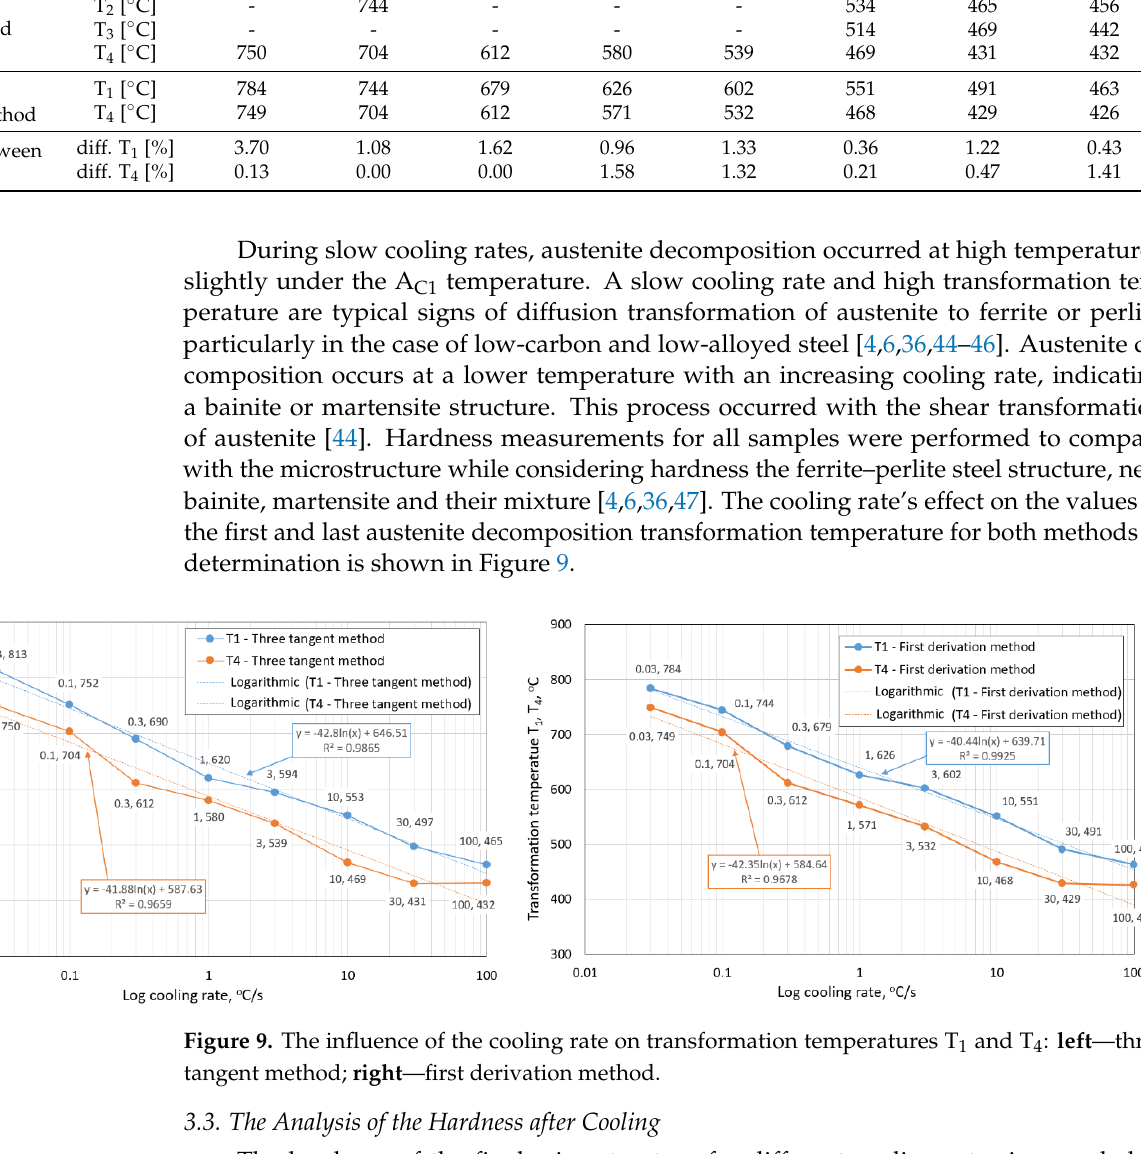
Table 7. The transformation temperatures of austenite decomposition.